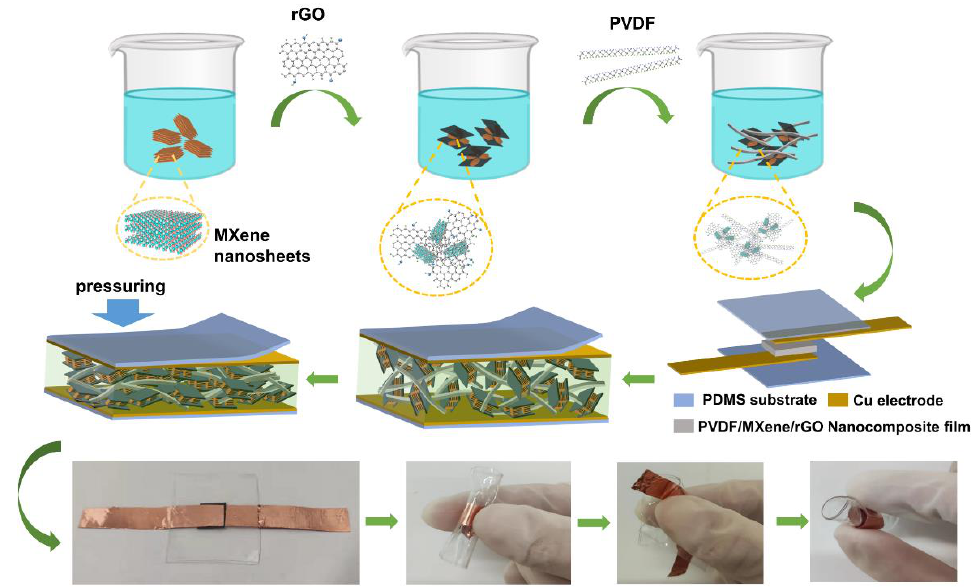
Figure 3. Schematic diagram of the PMR dual-mode flexible sensor.